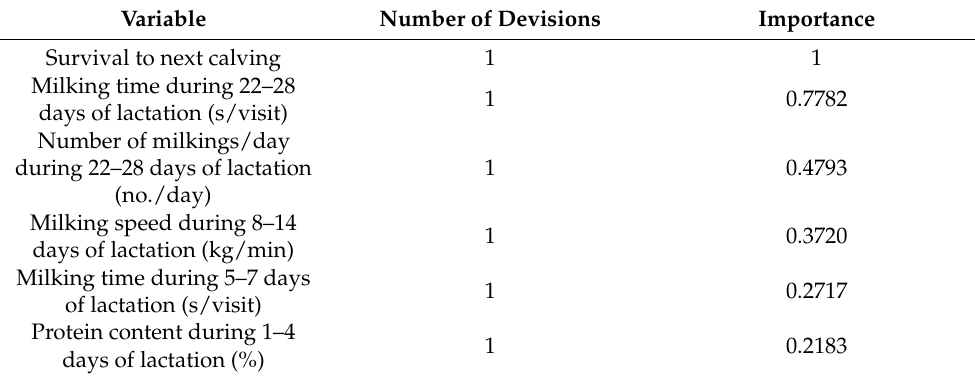
Table 5. The importance of tested variables based on “Importance”